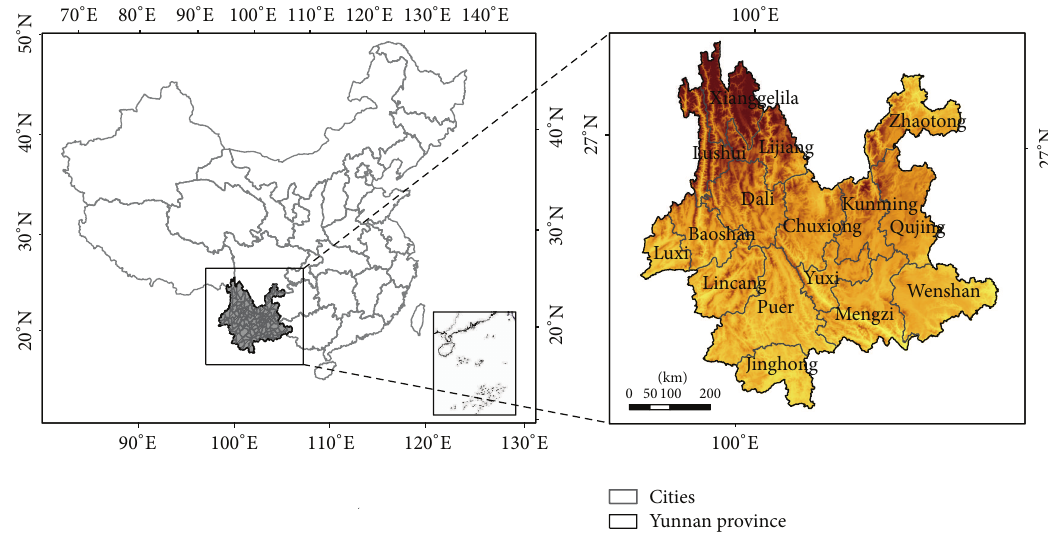
Figure 1: Location and DEM of Yunnan